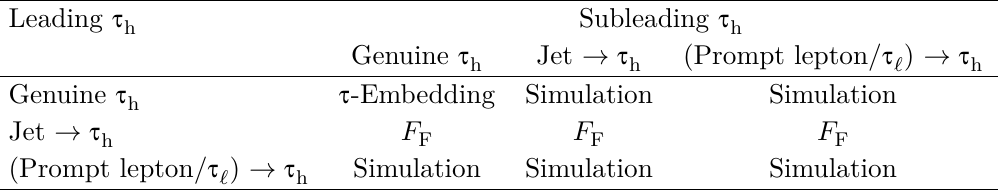
channel are shown in the rows and Table 3 . The different sources of backgrounds in the t h t h columns. The entries in the table represent the possible t lepton pair background contribution from different processes and misidentifications and encapsulate the different experimental techniques that are deployed to estimate the background contributions.